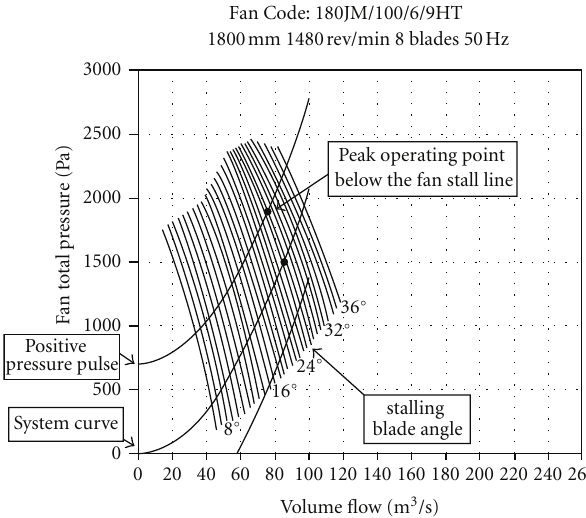
Figure 9: Optimum fan selections for a common duty point, fan selection strategy two: high-pressure